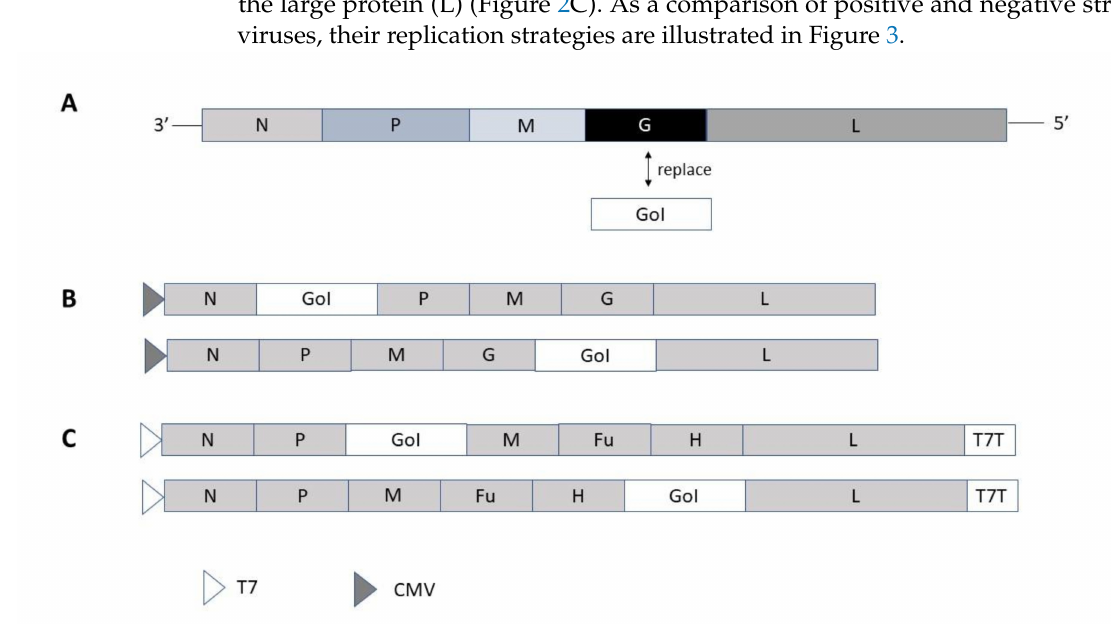
Figure 2. Self-replicating RNA viral vectors of negative polarity . ( A ) VSV vector for replacement of VSV G protein. ( B ) Rabies virus and ( C ). Measles virus expression vectors. CMV, cytomegalovirus promoter; Fu, fusion protein, G, glycoprotein; GoI, gene of interest; H, hemagglutinin; L, large protein; M, matrix protein; P. phosphoprotein; T7, T7 RNA polymerase promoter; T7T, T7 terminal sequence.